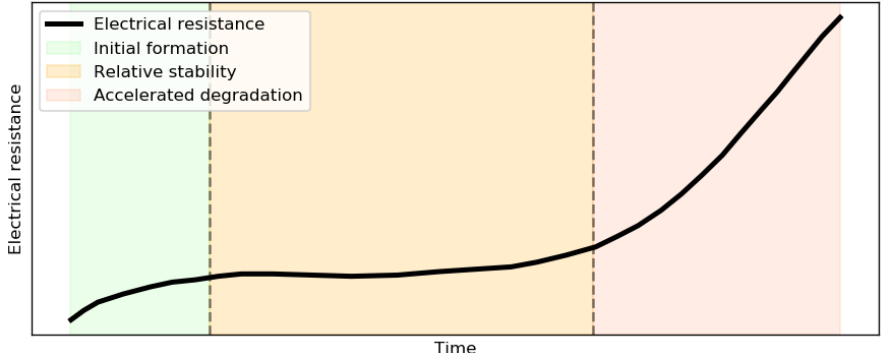
Figure 2. Evolution of the resistance of a power connector according to the IEC 61238-1-1 standard [25].